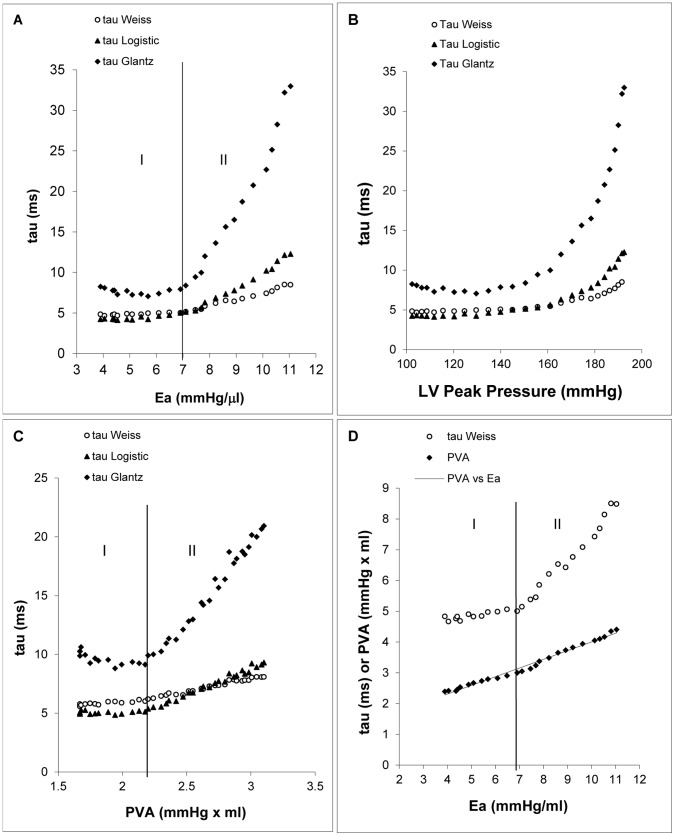
The relationship between τ, Ea, LV peak systolic pressure, and pressure-volume area (PVA).Plots of the three τ computations versus Ea (A), peak systolic pressure (B), and PVA (C) with phenylephrine injection. (D) Combined plots of τ () and PVA versus Ea (PVA = 282.63×Ea +1178.5, R2 = 0.9858).